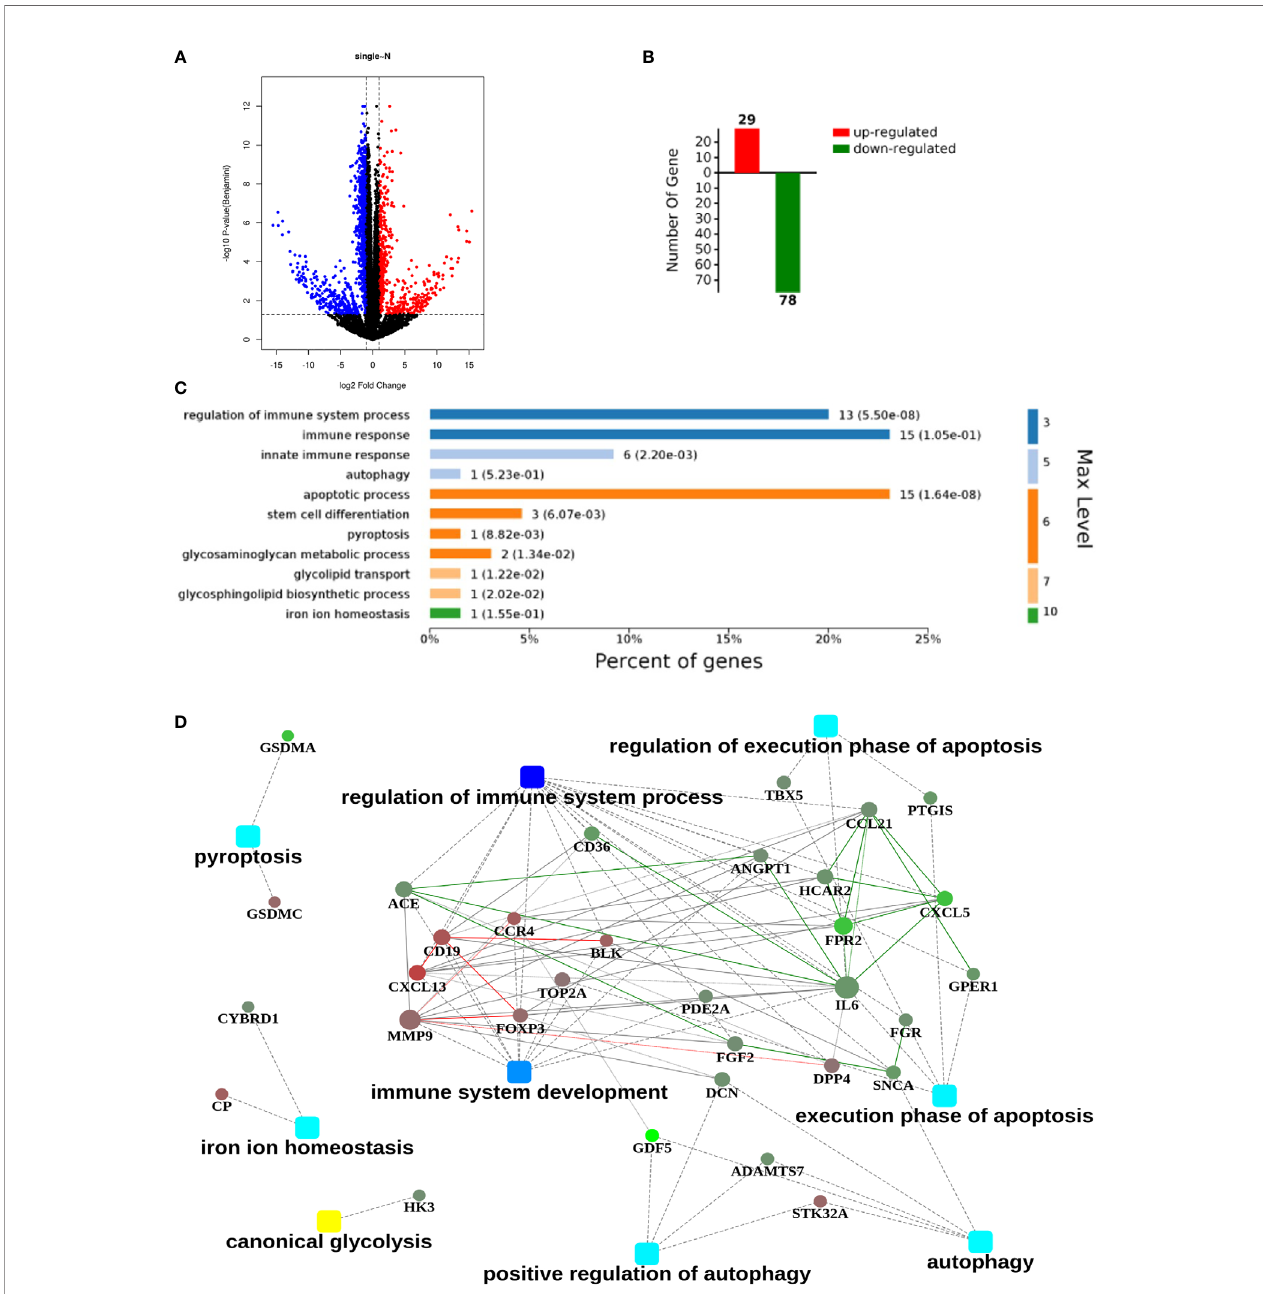
FIGURE 1 | An RNA sequencing (RNA-seq) analysis with 21 pairs of surgical GGO specimens and normal lung tissues from primary lung GGO patients. (A, B). Process of obtaining the up-regulated and down-regulated genes after RNA-seq in GGO (|Fold Change| ≥ 2, p<0.05). (C, D). Clustering of differentially expressed genes and the related hub genes in different pathways. Square nodes represent different pathways and round nodes represent hub genes; the size of the circle represents the number of nodes involved in hub